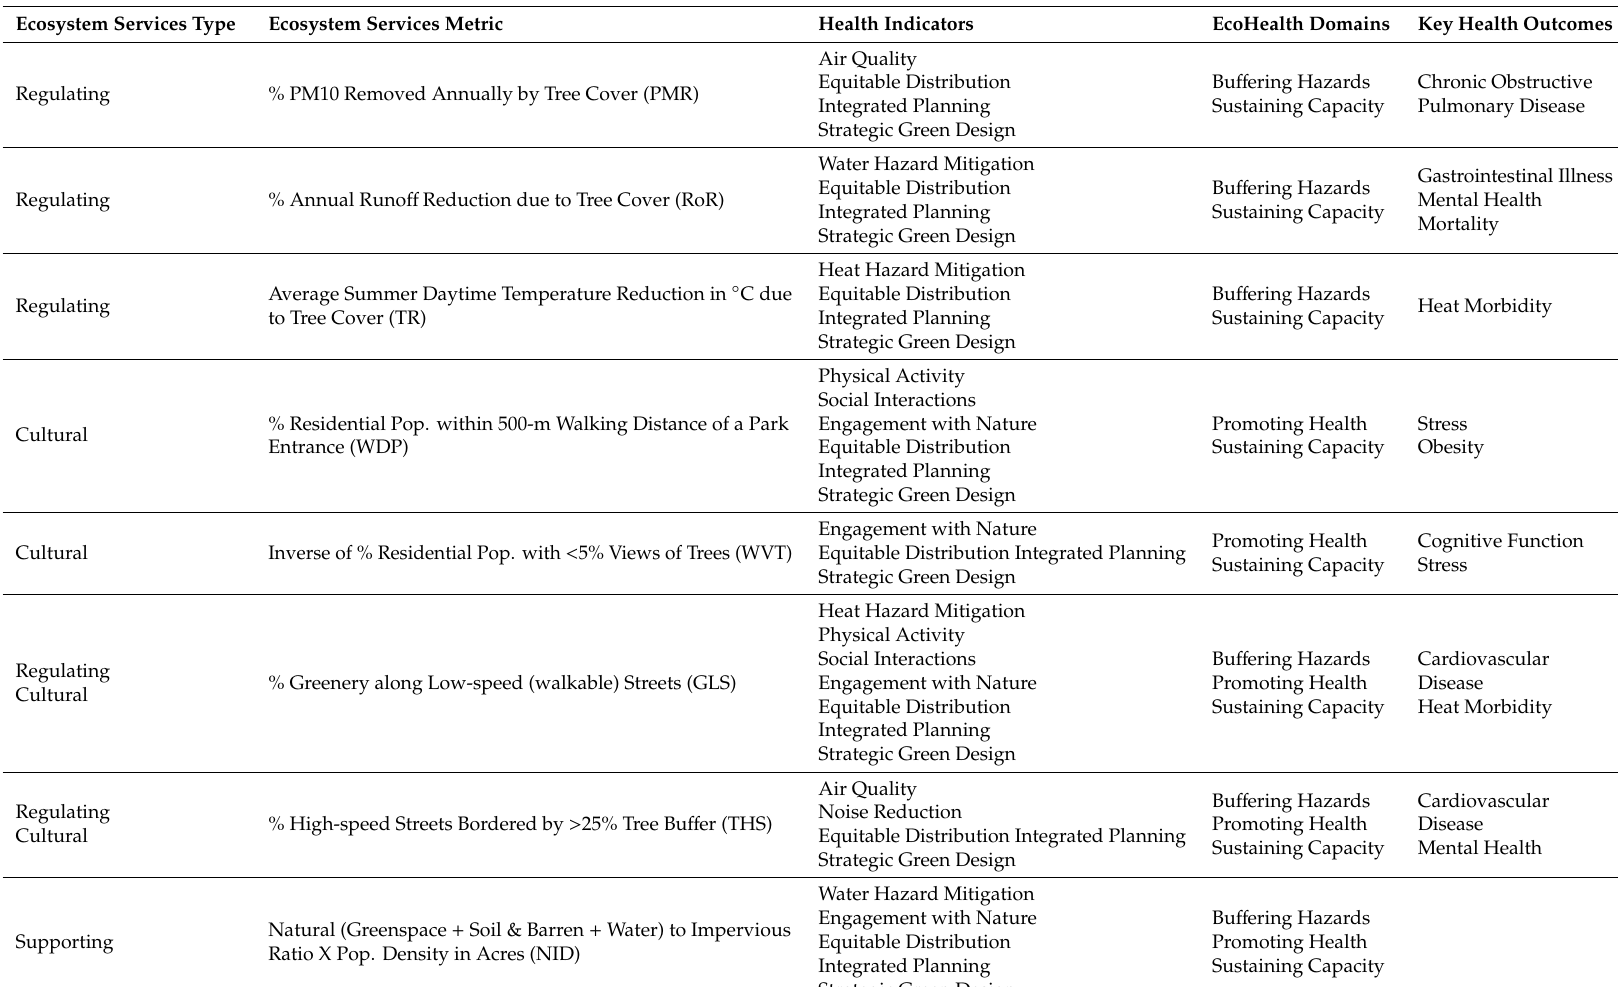
Table 1. The Community Ecohealth Index (CEHI) is comprised of eight metrics, each associated with an ecosystem services type, health indicators, ecohealth domains, and key health outcomes. ES metrics categorized as “providing” were not selected because they are minimal in urbanized